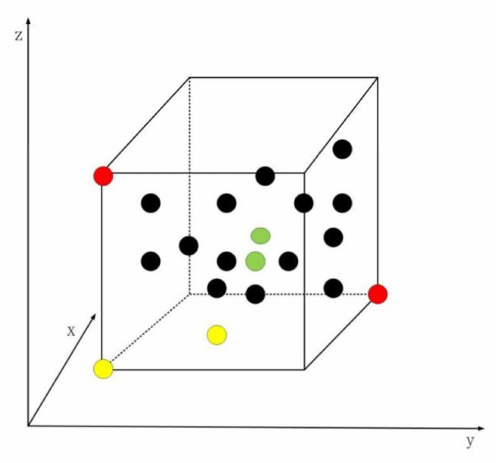
Figure 6. Dynamic image Pareto solution updates